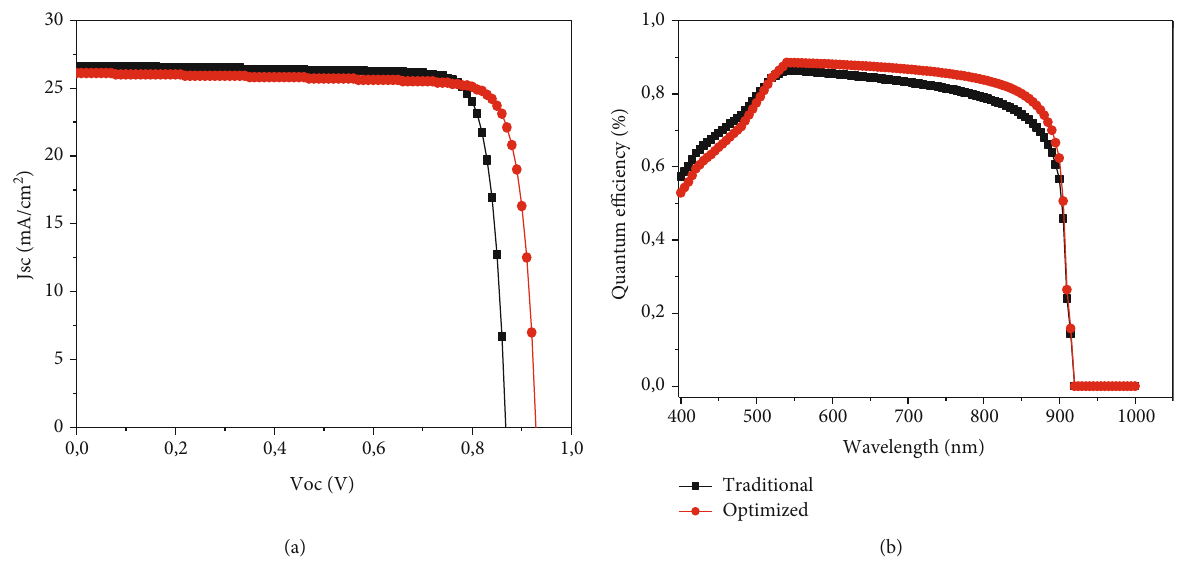
Figure 6: J-V characteristics and quantum e ffi ciency of traditional and optimized CFTS solar cells. Table 2: Output parameters for traditional and optimized CFTS solar